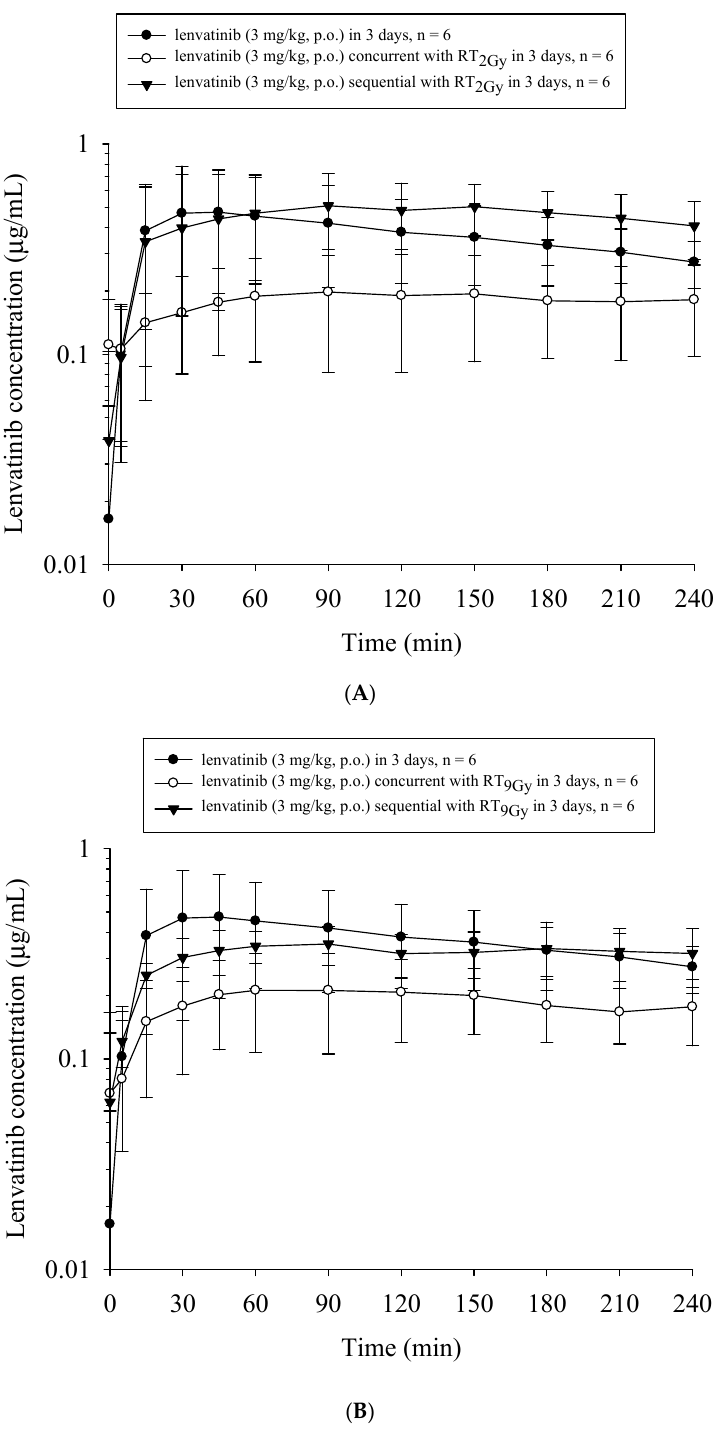
Figure 3. The concentration–time curves of lenvatinib in the plasma of rats under different treatment schedules with or without radiotherapy (RT). The treated groups in ( A ) included the sham group, which received lenvatinib (p.o., q.d. × 3d ) with RT 0 Gy (lenvatinib × 3d ); the concurrent group, which received lenvatinib × 3d 1 h after 3 fractions of RT 2Gy (RT 2Gy × 3f’x ); and the sequential group, which received lenvatinib × 3d 24 h after RT 2Gy × 3f’x . The treated groups in ( B ) included the sham group, which received lenvatinib × 3d ; the concurrent group, which received lenvatinib × 3d 1 h after RT 9 Gy in 3 fractions (RT 9Gy × 3f’x ); and the sequential group, which received lenvatinib × 3d 24 h after RT 9Gy × 3f’x . Data are expressed as the mean ± standard error of the mean ( n = 6 per